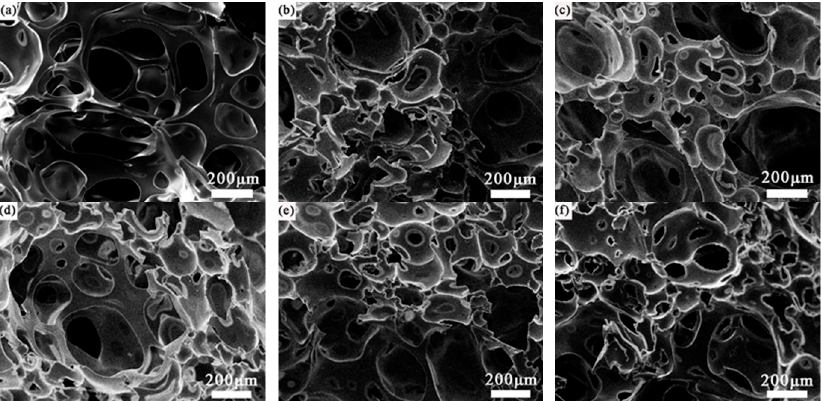
Figure 8. SEM images of TOPUF ( a ), TOPUF with 0.3 wt % ( b ), 0.6 wt % ( c ), 0.9 wt % ( d ), 1.2 wt % ( e ), and 1.5 wt % ( f ) ML